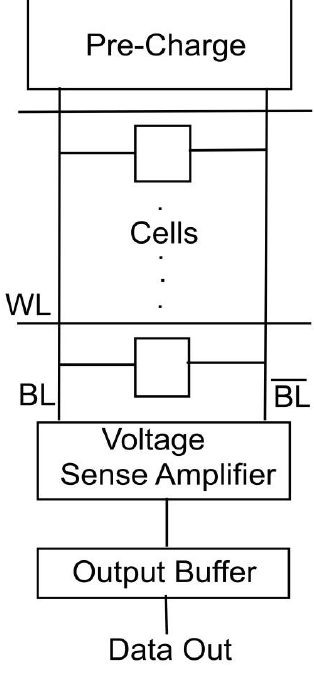
Figure 3. SRAM column with Sense Amplifier.